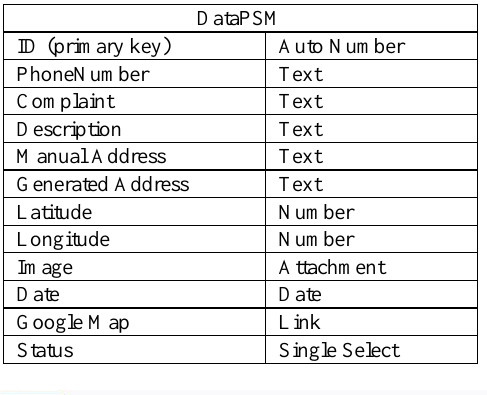
Table 1. Structure of table in Airtable.